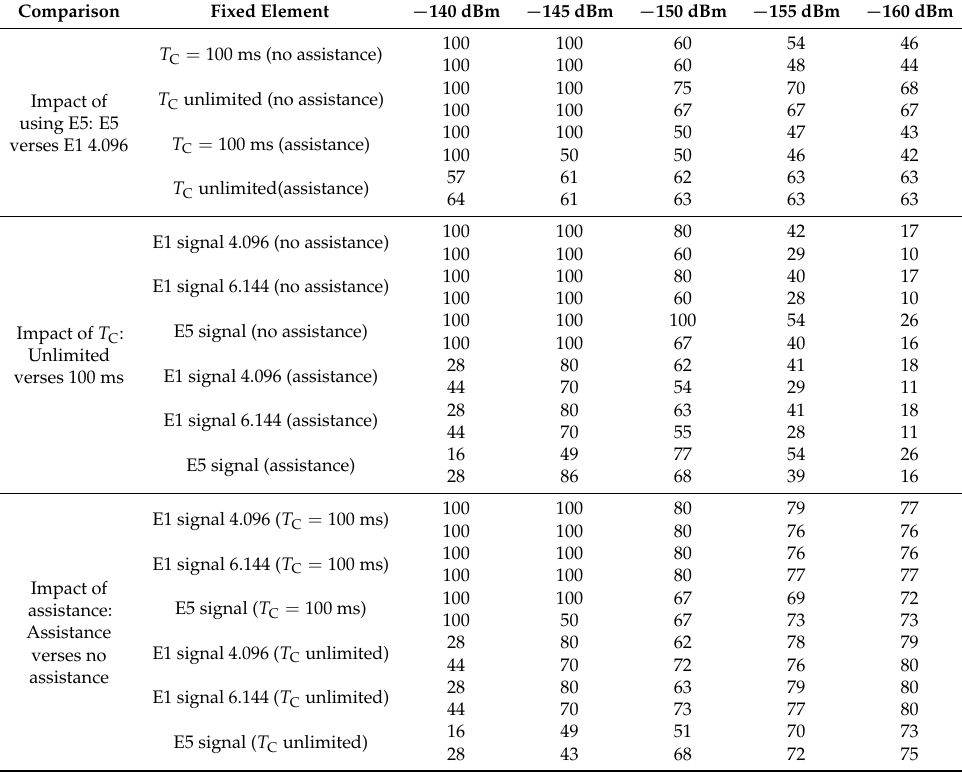
Table 18. Ratio of total integration time (%) for different comparisons with Galileo signals. Top value is for average losses, and bottom value is for worst losses. Note that the sensitivities given are for the L1 C/A signal; those of E1 are 1.5 dB lower and those of E5 are 0.5 dB